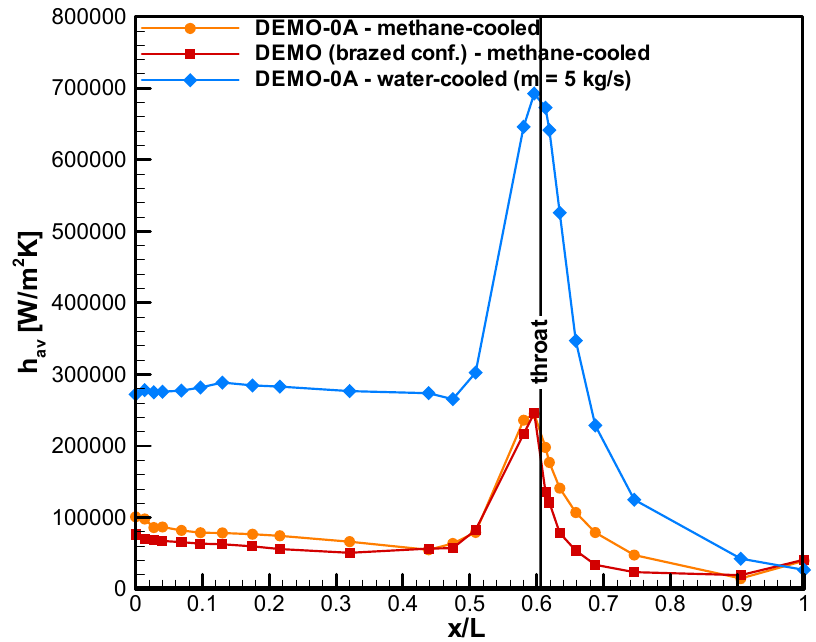
Figure 14. Convective heat transfer axial profiles.